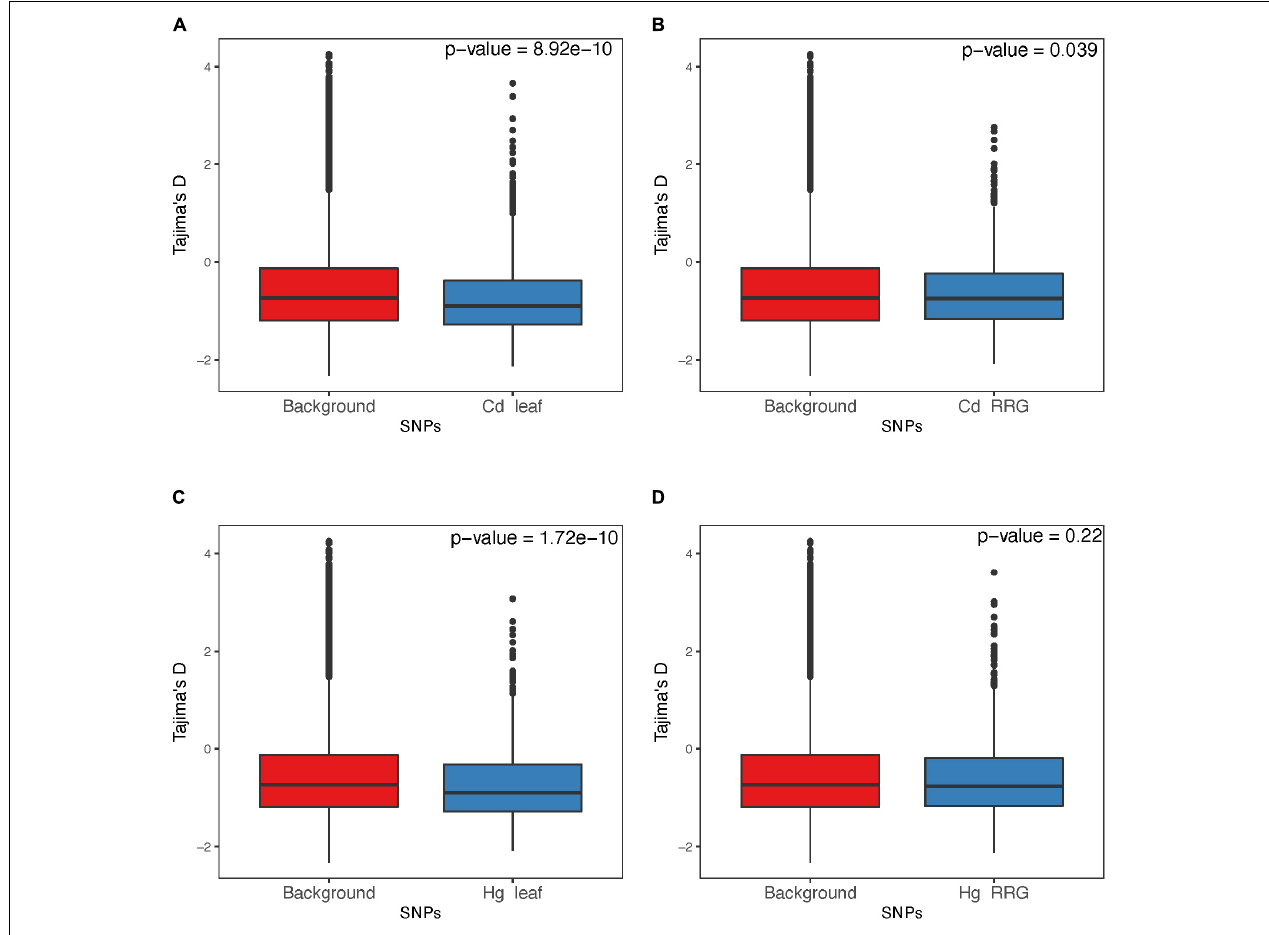
FIGURE 8 | Comparison of Tajima’s D from the genomic background and regions containing SNPs from the GWAS for the traits Cd leaf accumulation (A) , Cd relative root growth (RRG) (B) , Hg leaf accumulation (C) , and Hg RRG (D) . Tajima’s D was estimated using 10 bp regions surrounding focal